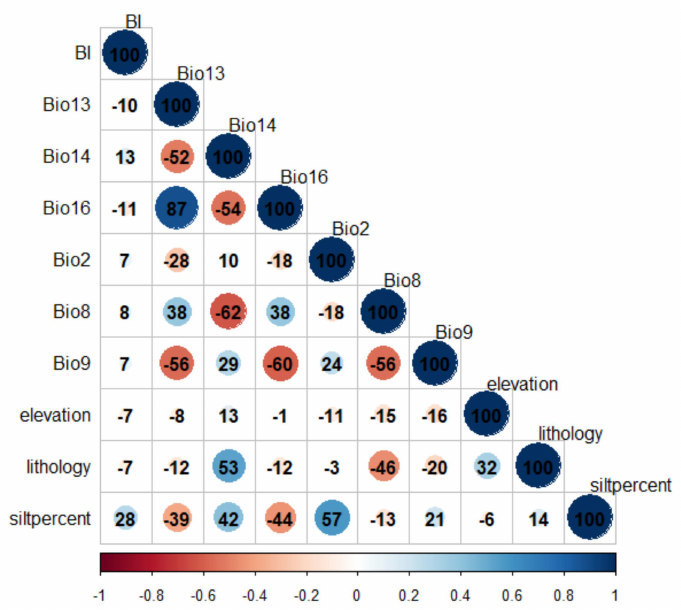
Figure 3. Correlation plot of the selected variables. The red-to-blue bar represents the correlation coefficient between variables, and the values in circles are correlation coefficient in percentage.